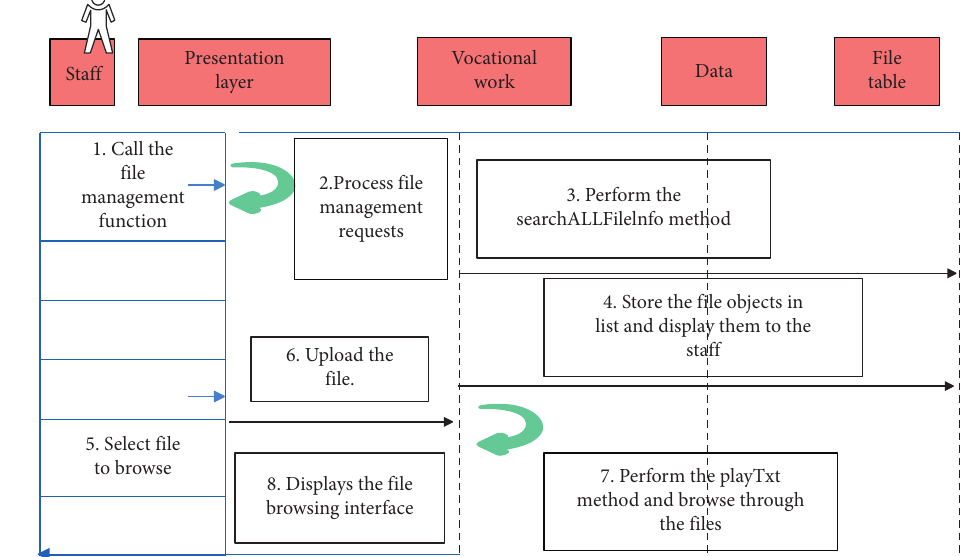
Figure 6: Sequence diagram of music resource file browsing function.